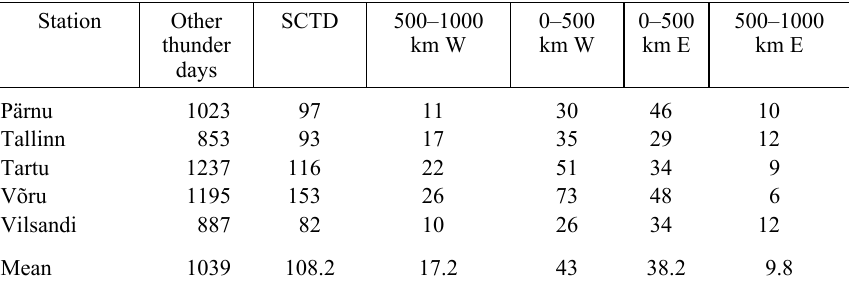
Table 1. Numbers of thunder days grouped by stations and by trajectories: cyclones moving from south to north and passing Estonia from the west (W) and east (E) in distance